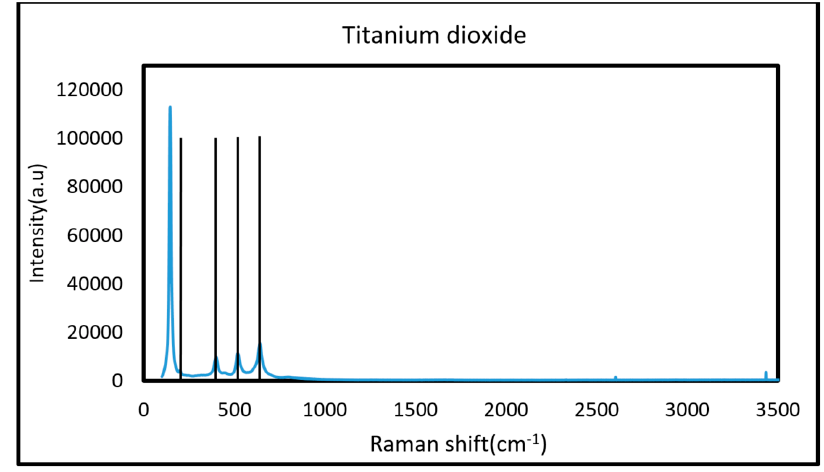
Figure 3. Raman spectroscopy of titanium dioxide nano particles.